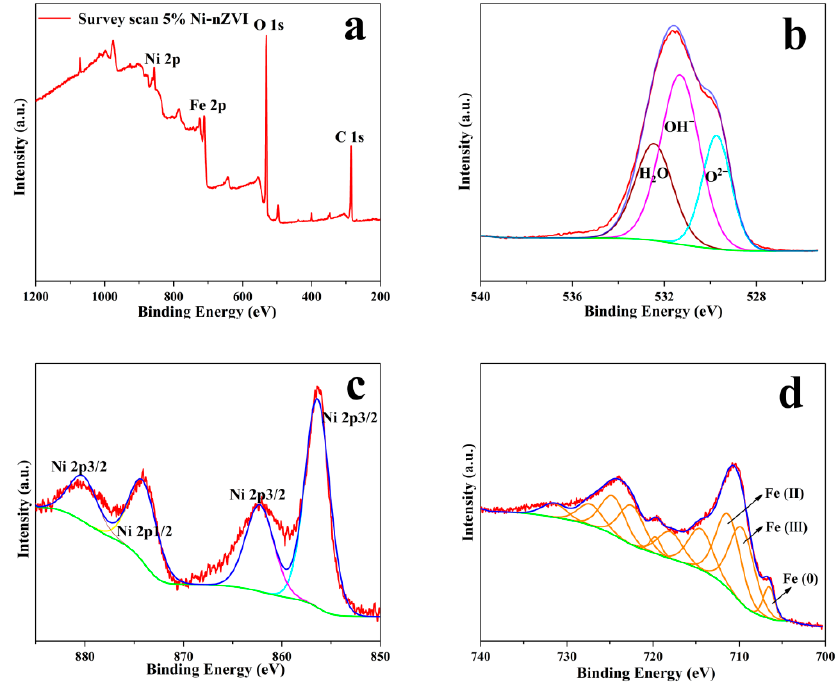
Figure 3. XPS analysis of 5% Ni-nZVI composite: ( a ) survey scans; ( b ) O1s; ( c ) Ni 2p; ( d ) Fe 2p.